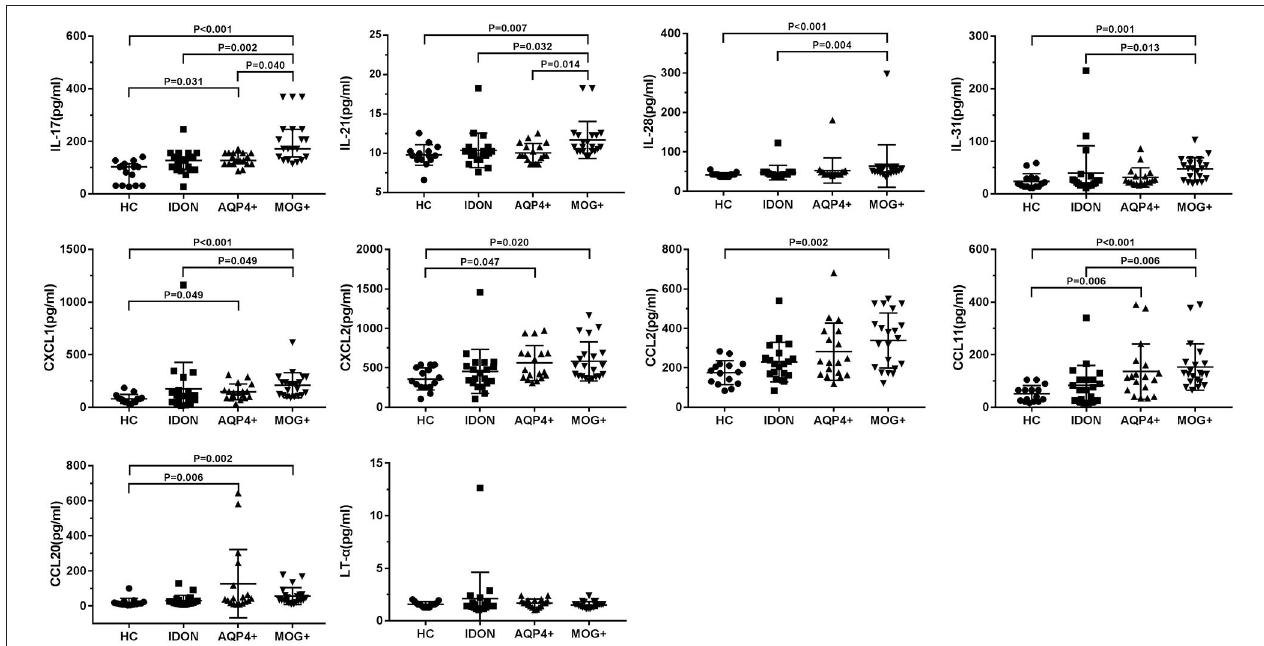
FIGURE 1 | Comparison of T-helper cell 17 (Th17)-related serum cytokine/chemokine levels between myelin oligodendrocyte glycoprotein antibody (MOG-IgG) + optic neuritis (ON), aquaporin 4 (AQP4-IgG) + ON, idiopathic demyelinating optic neuritis (IDON), and healthy controls.